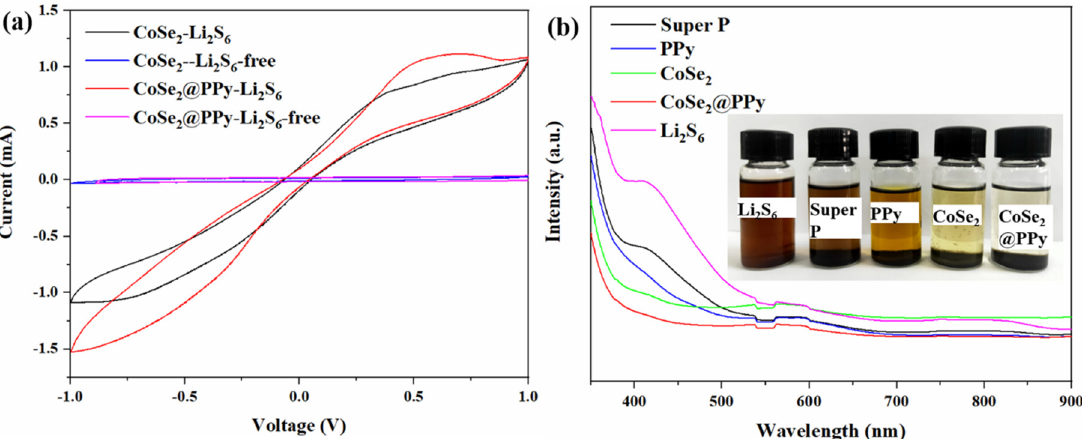
Figure 8. ( a ) CV curves of CoSe 2 and CoSe 2 @PPy composites between − 1.0 and 1.0 V at a potential sweep rate of 5 mV s − 1 . ( b ) UV–vis spectra and adsorption photographs of Li 2 S 6 solution with blank, super P, PPy, CoSe 2 , and CoSe 2 @PPy